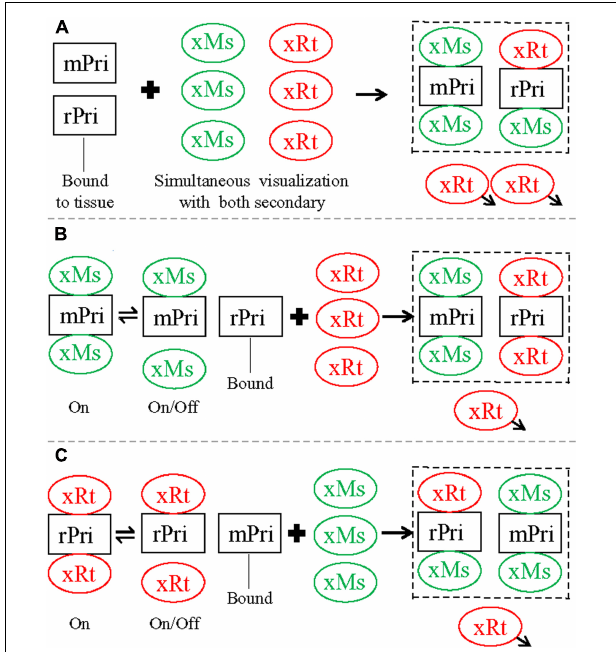
FIGURE 5 | Summary diagram illustrating staining pattern of different double staining protocols tested in the present study, closely related to Figure 2 . (A) Simultaneous protocol. After incubation, both mouse (mPri) and rat (rPri) primaries were bound to their designed antigens in tissue slices, and the excessive primaries washed away. Simultaneous visualization was then performed with a mixture of anti-mouse (xMs) and anti-rat (xRt) secondary. xMs would bind tightly to mPri for same-species reaction as expected. The excessive xMs would also compete well enough at binding to rPri to produce cross-species staining. xRt, by contrast, bound well to rPri for same-species staining but could not compete well against xMs for cross-species binding to mPri. As a result, mPri could be seen as pure green by xMs only, whereas rPri appeared as co-staining with both red (from xRt) and green (from xMs) fluorescence. When the staining stopped, the excessive secondary would be washed away ( arrowheads ). (B) Sequential protocol 1. Slices were first incubated with mPri and visualized with xMs consecutively, with excessive antibodies of this pair washed away. After second round incubation with rPri, xRt was used for visualization. Although xMs that was already bound to mPri would shift between on and off status, the excessive xRt in visualization medium would not displace xMs for cross-species binding to mPri, since xRt has weaker binding ability to the mouse primary (as speculated above). As a result, mPri kept being stained as pure green from xMs. rPri, on the other hand, would only be stained as red from xRt since there was no extra xMs this time for cross-species binding to rPri. (C) Sequential protocol 2. Slices were first stained with rPri and visualized with xRt consecutively, with excessive antibodies of this pair washed away. After second round of incubation with mPri, xMs was used for visualization. xRt that was already bund to rPri would shift between on and off status at this time. While xMs preferred to bind to mPri, the extra xMs in visualization medium would displace some of xRt for cross-species binding to rPri. As a result, rPri that had been coupled with xRt (red) would be changed to co-staining as red and green from both